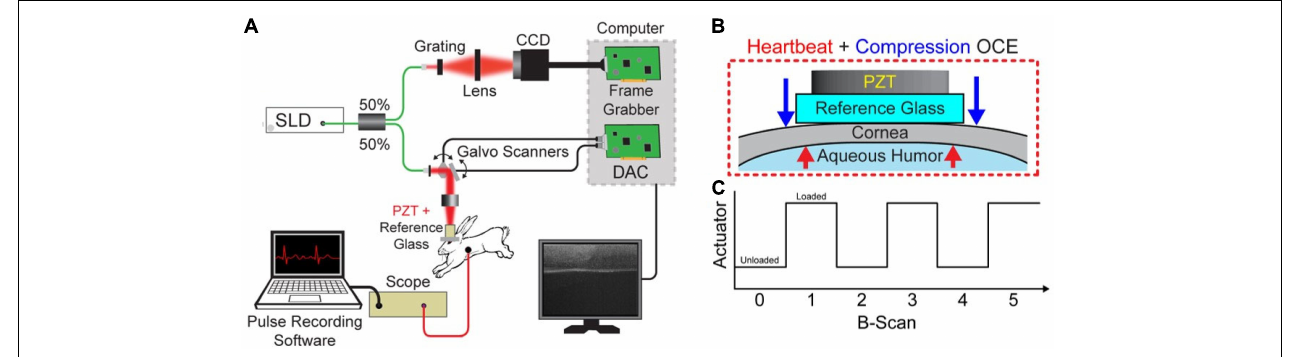
FIGURE 1 | (A) Schematic of the combined Hb+Compression OCE system. (B) Zoomed in view of the interface between the reference glass and cornea with visualization of the forces acting on the cornea. The blue arrow indicates the compression force applied by the piezoelectric transducer (PZT), and the red arrows illustrate the force applied by the hearbeat-induced ocular pulse. (C) PZT actuation as a function of image acquisition, where each B-scan took 16 ms. Hb-OCE data was acquired between two images of the same state (i.e., B-scan 0 versus B-scan 2), and compression OCE measurements were acquired between images of opposite states (i.e., B-scan 0 versus B-scan